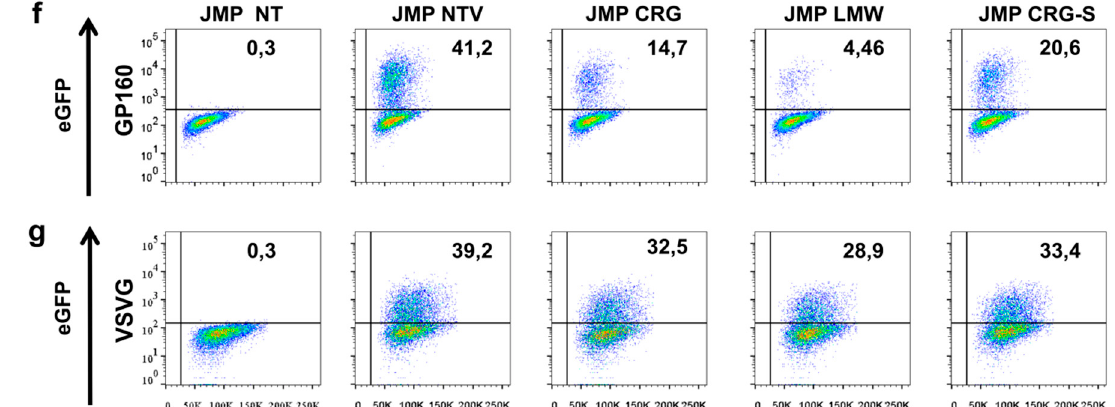
Figure 6. Antiviral action of κ / β -CRG and their oligosaccharide (LMW) against replication defective viruses pseudotyped with HIV-1 GP160 or VSVG envelope proteins. ( a ) Scheme of the experiment. The recombinant plasmid LeGO G2 encoding marker protein GFP, plasmid encoding structural proteins (gag-pol) and one of three plasmids encoding envelope proteins (env) were used for generation of RDLVs, pseudotyped with HIV-1 envelope protein GP160, vesicular stomatitis virus VSVG or endogenous retrovirus McERV. Jurkat JMP (spherical) or Lan-1 (fibroblast-like) cells were treated with CRG and used for trunsduction. The percentage of transduced cells (colored with green) was analyzed by flow cytometry ( b ) The viability of Lan-1 cells treated with CRG, LMW and CRG-S in concentration range up to 100 µ g/mL. ( c ) The viability of Jurkat JMP cells treated with CRG, LMW and CRG-S in a concentration range up to 100 µ g/mL. ( d ) Percentage of GFP-positive Jurkat JMP cells measured by flow cytometry 72 h after adding supernatans containing GP160-pseudotyped RDLVs at presence of CRG ( κ / β -CRG, LMW, Car-S). NT: non-transduced cells and not treated with CRGs, NTV: transduced cells but not treated with CRGs were used as controls. ( e ) Percentage of GFP-positive cells measured by flow cytometry 72 h after adding supernatants containing VSVG-pseudotyped RDLVs at presence of CRGs. ( f ) Flow cytometry analysis of Jurkat JMP (JMP) cells transduced with RDLV-GP160 and treated with CRGs. ( g ) Flow cytometry analysis of Jurkat JMP (JMP) cells transduced with RDLV-VSVG and treated with CRGs. * p < 0.05, ** p < 0.005 as calculated by Mann–Whitney non-parametric test.